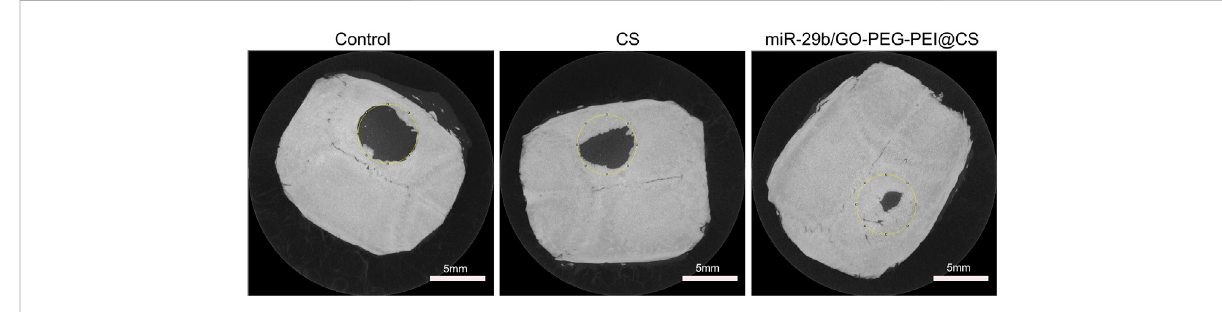
FIGURE 9 Typical microCT images of rats ’ skull defect without material covering or being covered by CS or miR-29b/GO-PEG-PEI@CS hydrogels after 2 months.